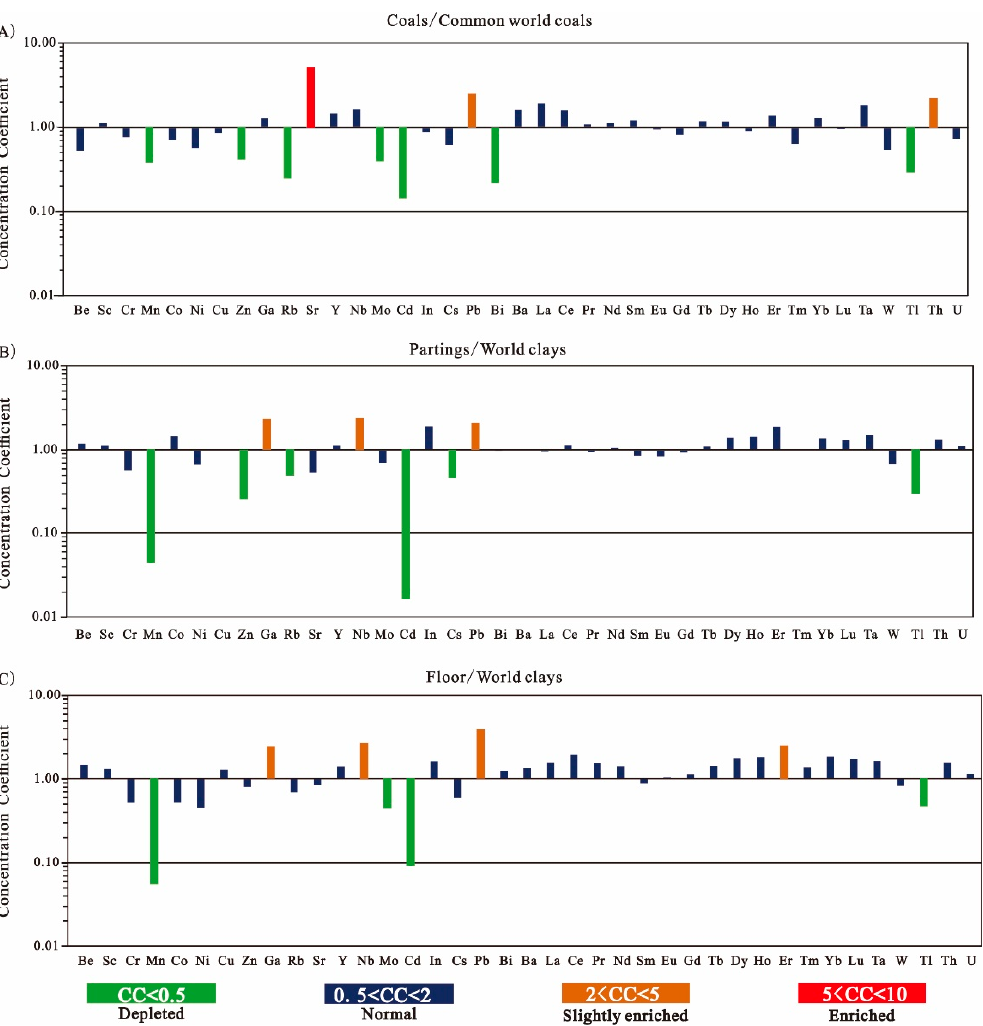
Figure 7. Concentration coefficients (CC) of trace elements in ( A ) the coal samples, ( B ) parting samples, and ( C ) floor sample from the Hebi No. 6 mine. The trace elements concentrations in the coal samples were normalized by the average trace element concentrations of world hard coals [69]. The trace elements concentrations in the partings and floor samples were normalized by the average trace element concentrations of the world clays [90].